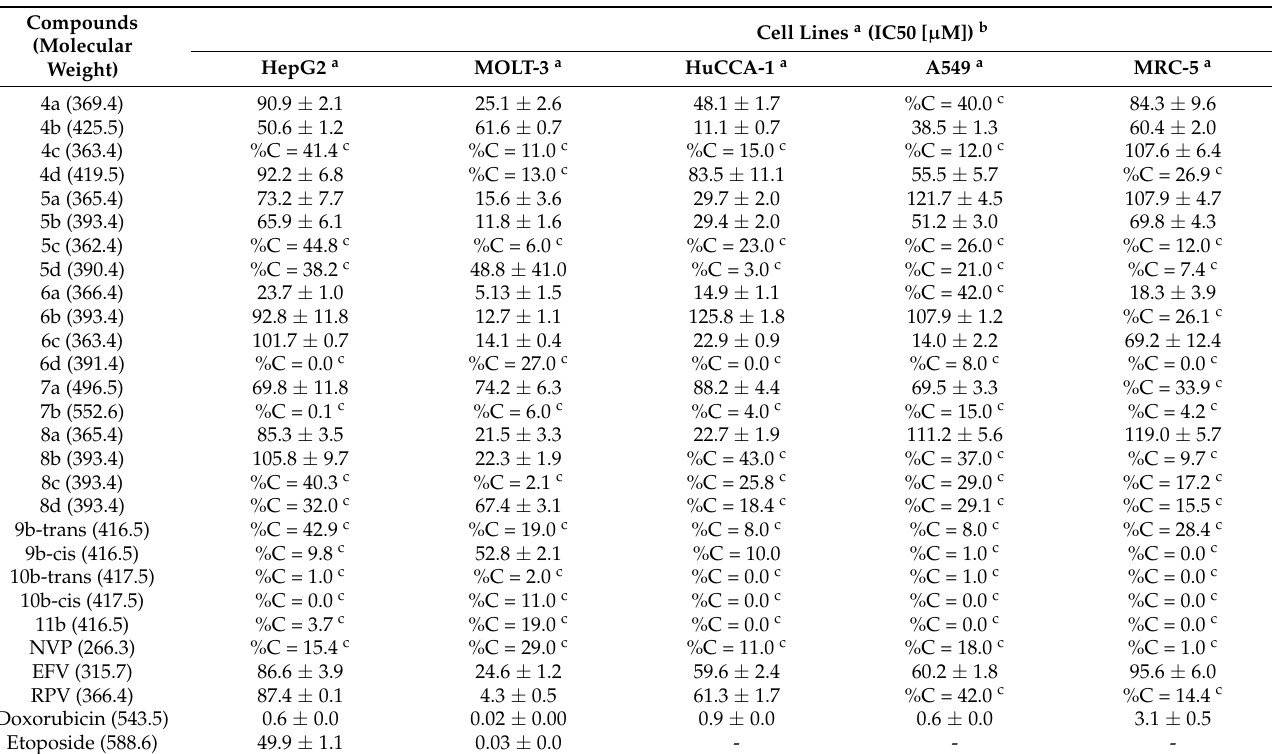
Table 4. In vitro cytotoxicity of the derivatives and commercially available drugs to human cancer cell lines and normal cell